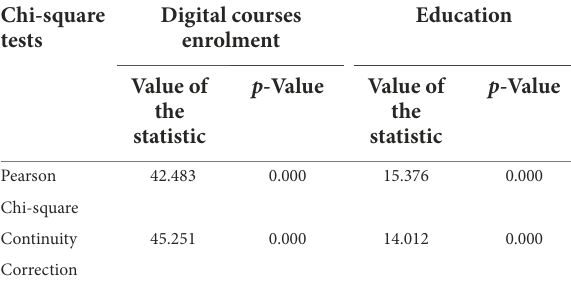
TABLE 4 Results of testing the differences between Belgium and Romania regarding digital courses enrolment and education. Chi-square